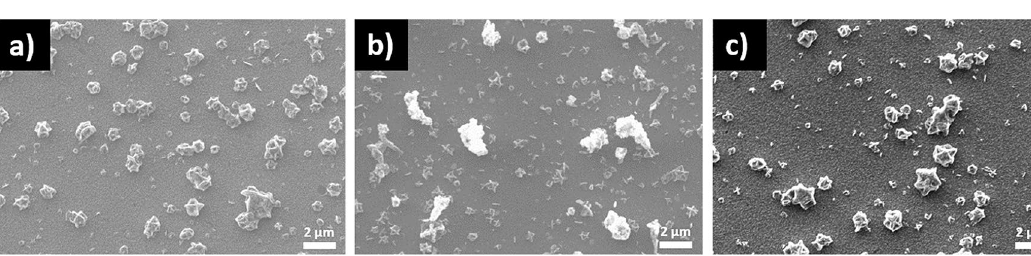
Figure 10. SEM images of the SLG\Cu\SnS 2 samples annealed in Sn + S atmosphere. Annealing was performed at ( a ) 350, ( b ) 500 and ( c ) 550 °C.